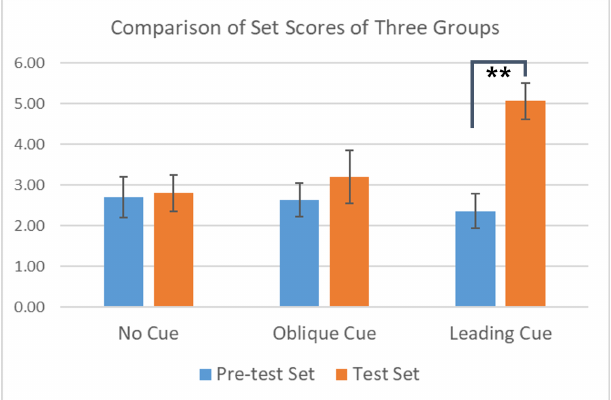
Figure 3. Comparison of set scores of three groups (NC: no cue, OC: oblique cue, and LC: leading cue). A double asterisk indicates statistically significant difference ( p <0.01).